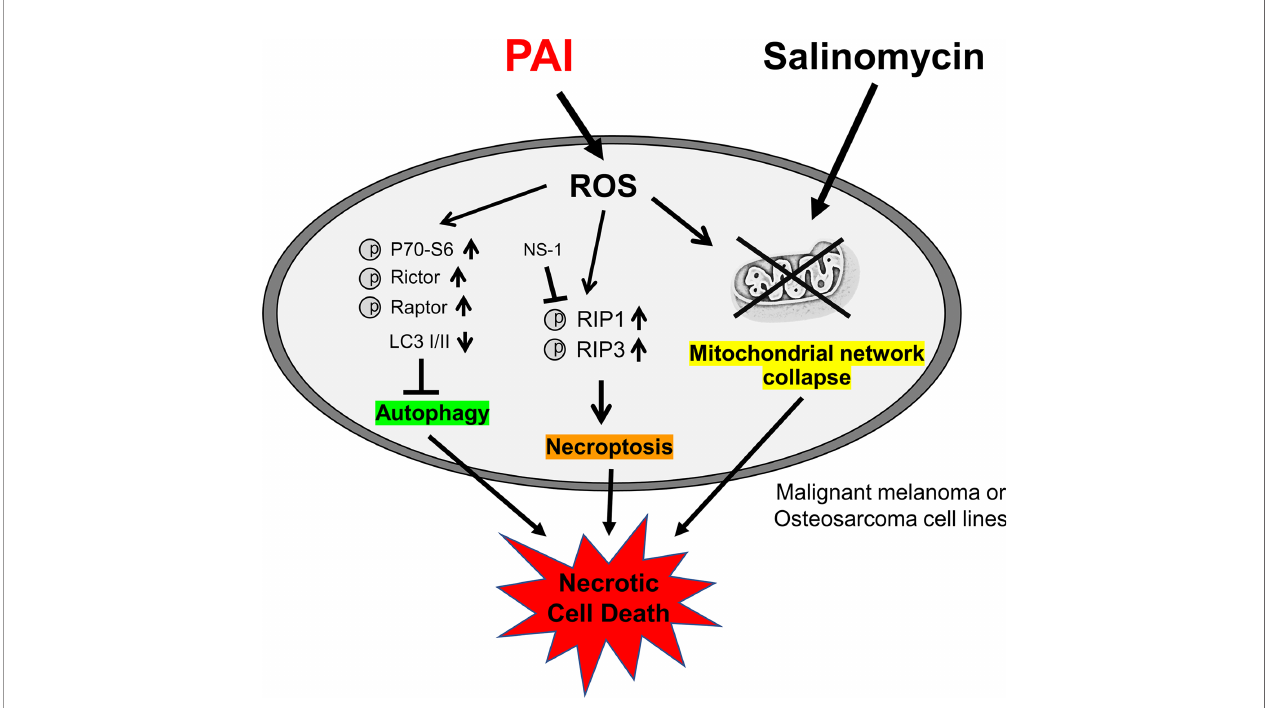
FIGURE 8 | Graphical abstract of this study. PAI evokes necroptosis by RIP1/3 kinase activation while suppressing cytoprotective autophagy via mTORC 1/2 activation, and ROS may play a role in these effects. PAI also causes mitochondrial network collapse and dysfunction via ROS generation. Salinomycin may enhance mitochondrial aberration. All these events could contribute to the anticancer effect of PAI via necrotic cell death